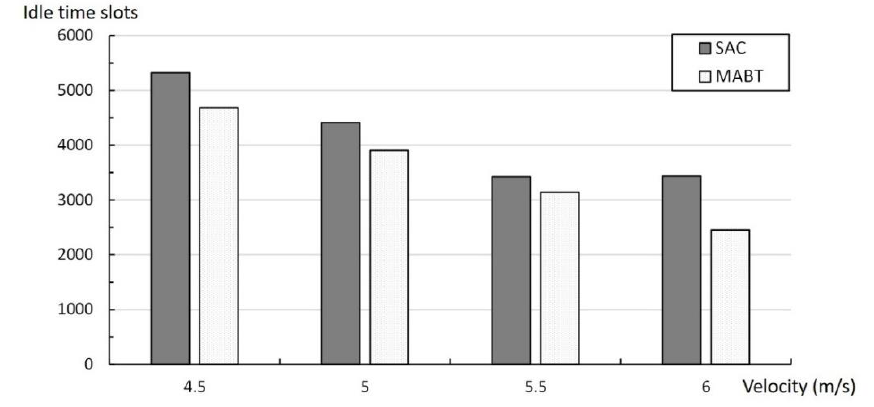
Figure 15. Total number of time slots used at different rates.